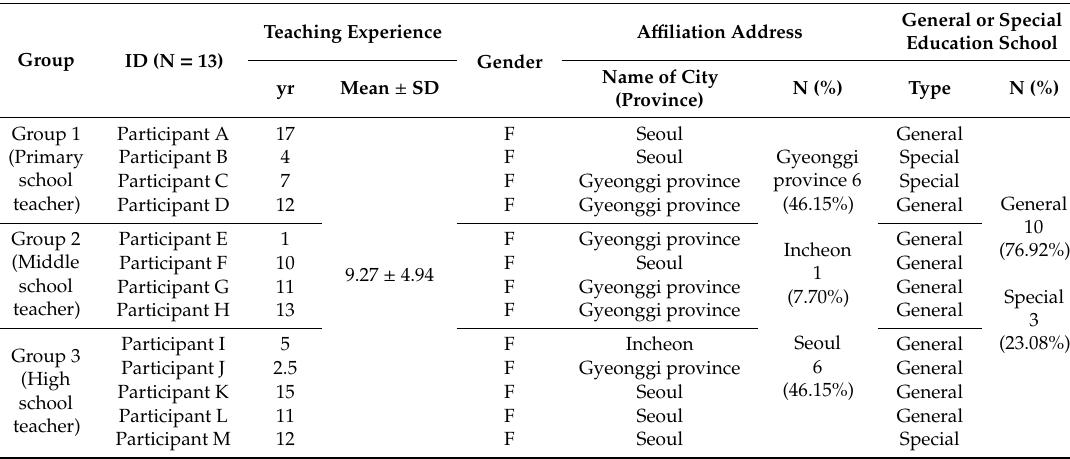
Table 1. Participants’